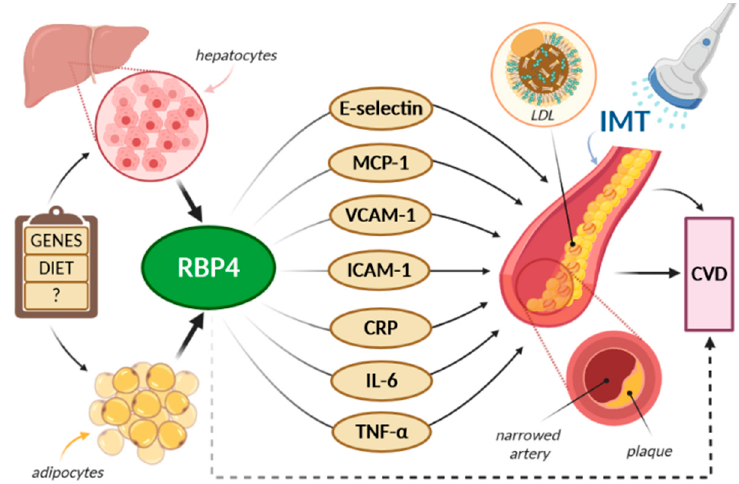
Figure 4. The potential pathomechanism of RBP4’s impact on atherosclerosis and CVD risk. E-selectin: endothelial-leukocyte adhesion molecule; MCP-1: monocyte chemoattractant protein 1; VCAM-1: vascular cell adhesion molecule 1; ICAM-1: intercellular adhesion molecule 1; CRP: C reactive protein; IL-6: interleukin-6; TNF- α —tumor necrosis factor α .